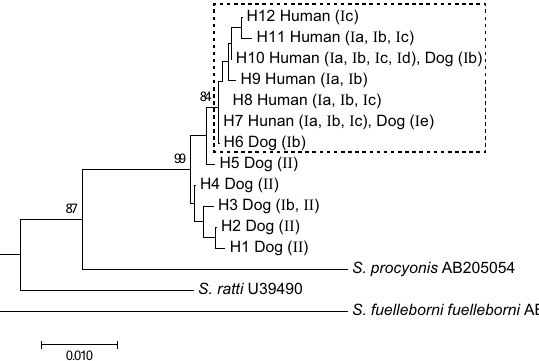
Figure 3. Neighbor-joining tree built for Strongyloides isolates using a portion of the nuclear 28S rDNA gene. MEGA7 software was used to build the tree using a dataset of 28S rDNA (743 nucleotide positions) gene haplotypes based on the Tamura-Nei model. A square depicted by a dashed line indicates a distinct clade, composed of haplotypes H6–H12. Letters inside the brackets indicate the Cox1 clade to which each isolate belongs with respect to the 28S rDNA haplotype of each sample.